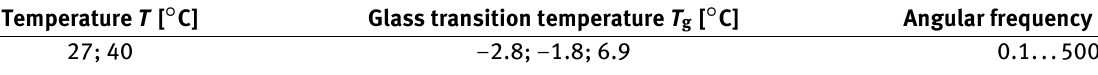
Table 2: Test parameters – torsion bar tests Temperature T [ ∘